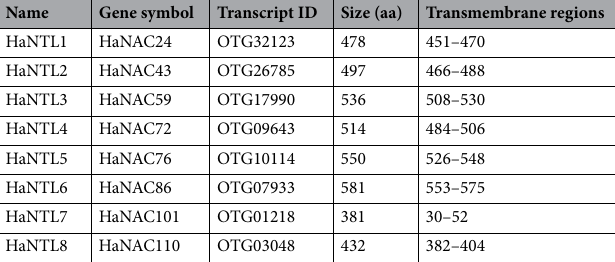
Table 1. Putative membrane-bound NAC transcription factors in